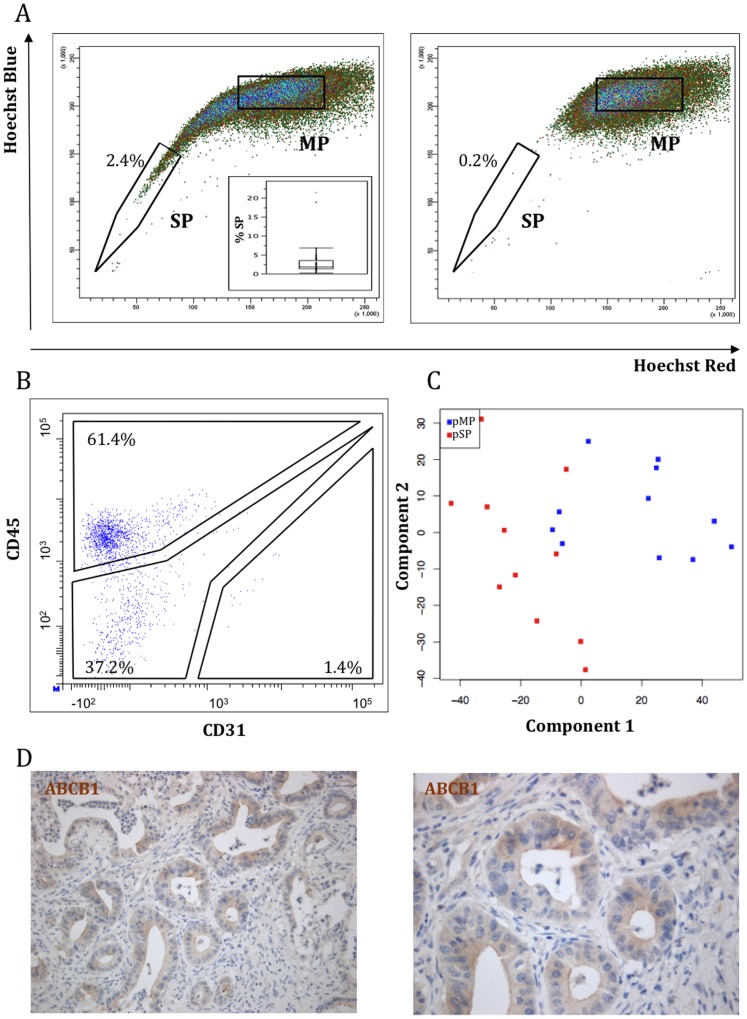
Identification and molecular characterization of the human PDAC SP.A) Dot plot of dual-wavelength FACS analysis of fresh human PDAC cells after incubation with Hoechst33342 depicting a tail of ‘Hoechst-low’ cells (SP), relative to a larger bulk of ‘Hoechst-bright’ cells, the main population (MP) (left panel). A representative example is shown and the SP proportion indicated. PIpos (dead) cells were excluded from analysis for Hoechst33342, CD45 and CD31 labelling. The boxplot (inset) summarizes the SP proportions of the 52 PDAC samples analyzed. Verapamil blocks Hoechst efflux, thereby reducing the SP size and confirming the SP phenotype (right panel). B) FACS dot plot of the PDAC SP, immunostained for CD45 and CD31. A representative example is shown. Numbers indicate the proportions of CD45+, CD31+ and CD45−/CD31− cells within the SP. C) Principal Component Analysis (PCA) of whole genome expression profiles obtained from CD45−/CD31− SP (pSP, red) and CD45−/CD31− MP (pMP, blue) (n = 11). D) Immunohistochemical staining of ABCB1 in PDAC resection samples (n = 11). A representative example (4% SP in FACS analysis) is shown. Original magnification: x200 (left) and x400 (right).